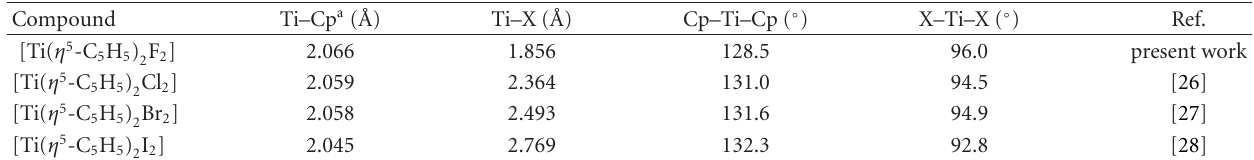
Table 3: Comparison of some important molecular parameters (average values) for the four prototype titanocene dihalogenides, [Ti( η 5 -